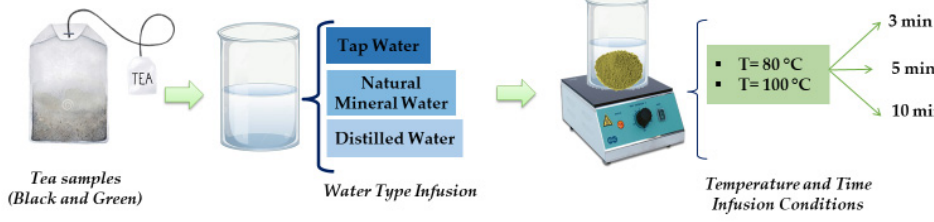
Figure 2. Experimental and water extraction conditions for tea samples.